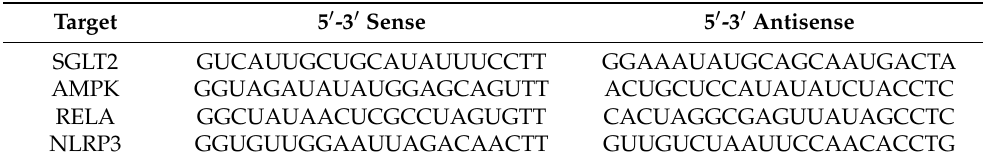
Table 1. Sequences of the small interfering RNAs used in this